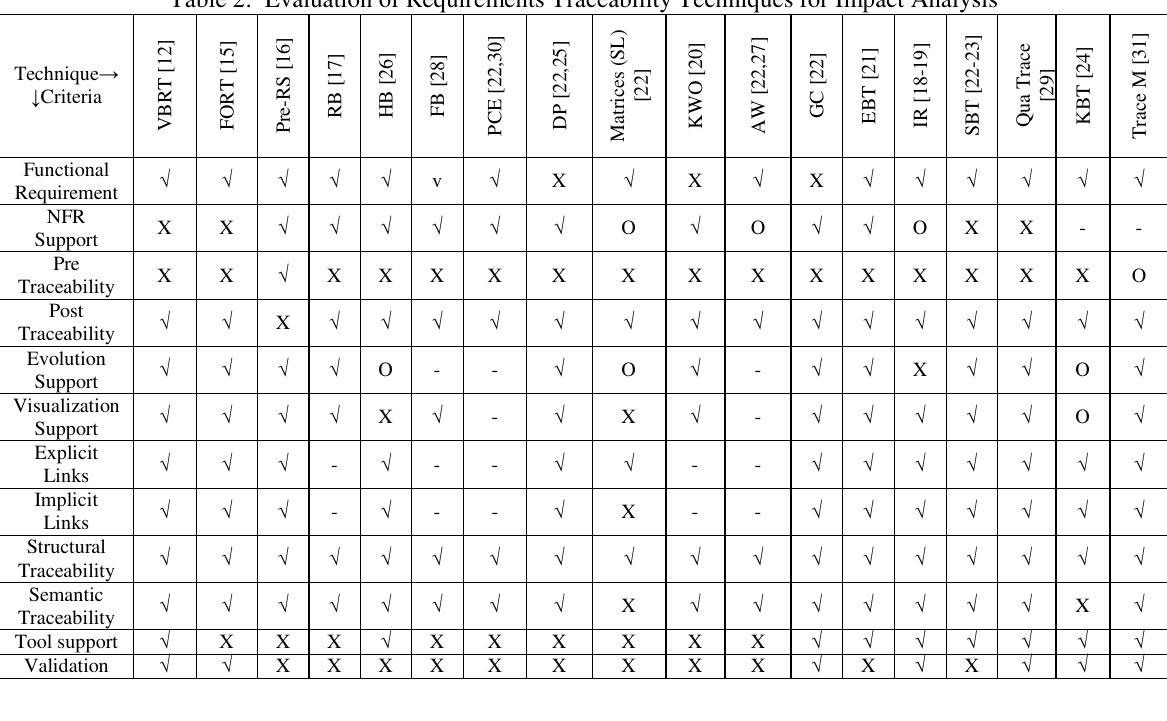
Table 2: Evaluation of Requirements Traceability Techniques for Impact